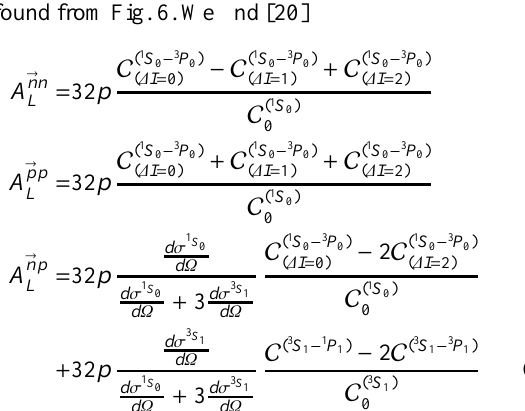
Fig. 6. PV NN scattering leading order diagrams. The box is one of the PV operators, the bubble sum in the second term is the S -wave rescattering.